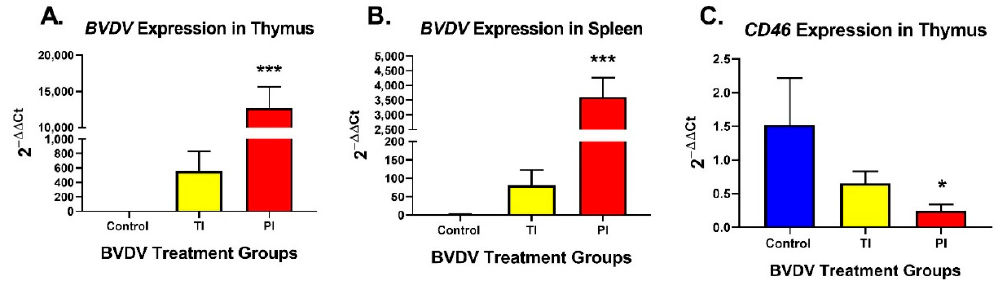
Figure 1. Bovine Viral Diarrhea Virus (BVDV) expression in ( A ) thymus and ( B ) spleen samples (Control, TI, and PI). Expression of BVDV was significantly upregulated in PIs compared to controls in both thymic and splenic samples. Expression of BVDV in TIs was higher than controls, but not significant due to individual variation. ( C ) BVDV receptor CD46 expression in thymus (Control, TI, and PI). CD46 expression was significantly down-regulated in PI thymuses. Control: Uninfected, blue; TI: Transiently Infected, yellow; PI: Persistently Infected, red. * p < 0.05, *** p < 0.001.